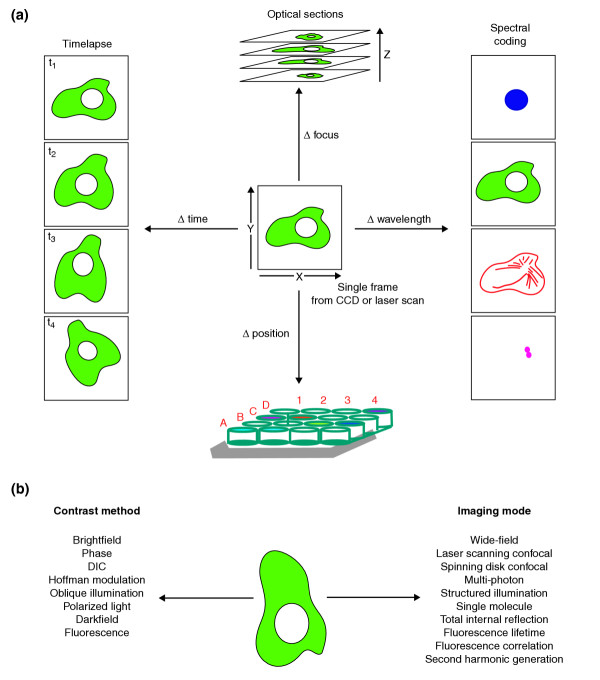
The mode of acquisition defines the pixel image data. The meaning of a 2D-image recorded from a digital microscope imaging system varies depending on how it is collected. Almost all of the different modes in (a) and (b) can be combined to analyze cell structure and behavior. All of the parameters and configurations must be somehow recorded for the interpretation of the pixel data in an image. (a) The spatial, spectral and temporal context of an image is used to generate more information about the cell under study. Changing stage position, focus, spectral range or time of imaging all expand the meaning of an image. Modified from [33]. (b) The two aspects of the image data collection that define the pixel data. A variety of methods are used to generate contrast in modern biological imaging. In addition, the imaging method used to record the data also has meaning.